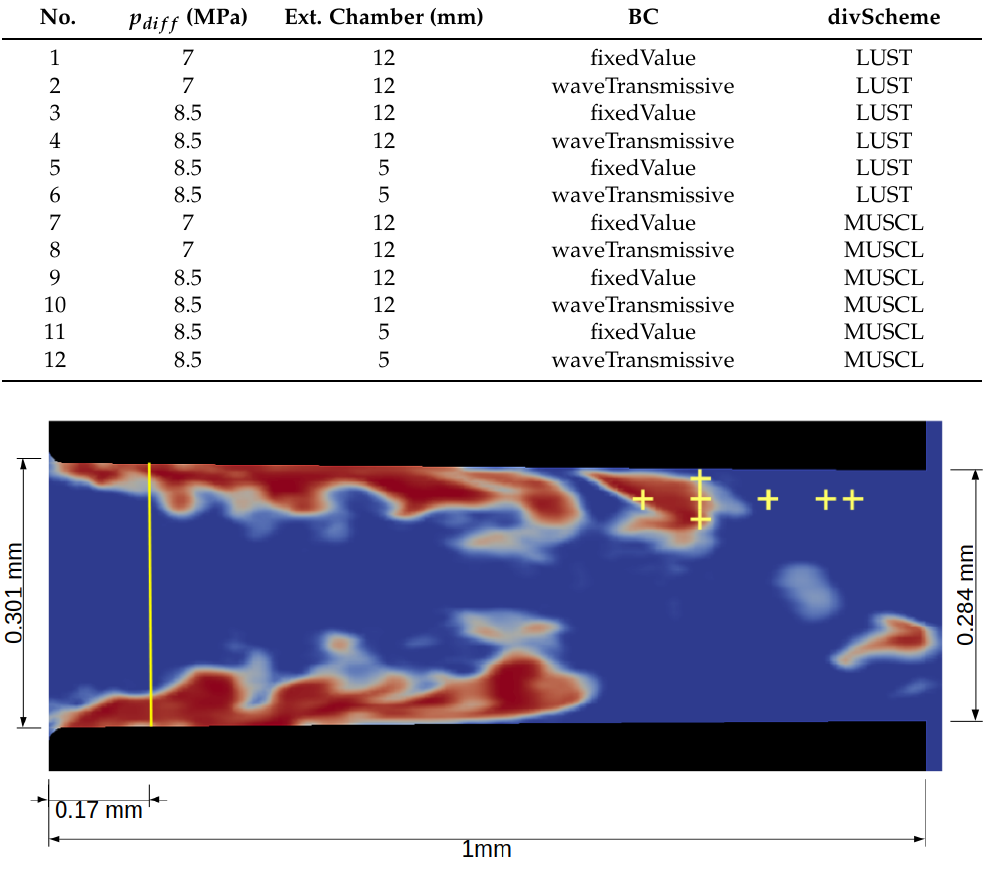
Figure 2. Nozzle dimensions with locations within nozzle for plots and computational probe locations for frequency analysis. The channel is 0.3 mm deep. Table 2. Radial and Probe locations (mm) (origin centre of nozzle entry). Probe